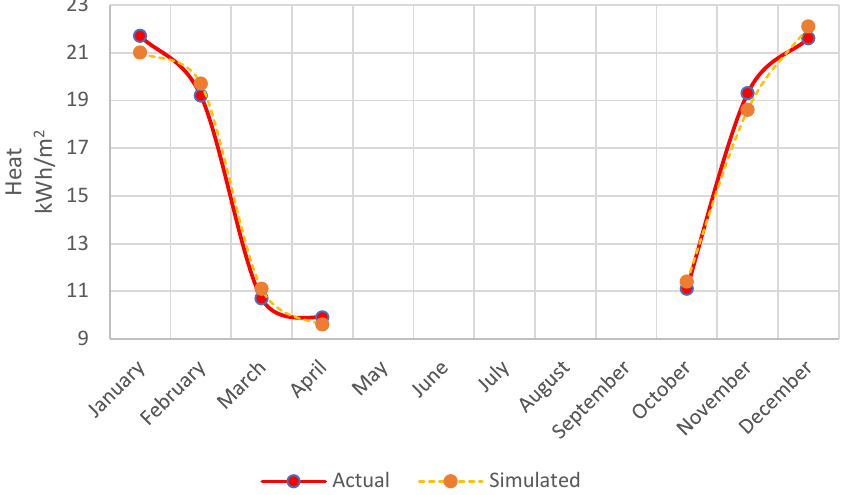
Figure 9. Validation — actual heat consumption and simulated demand of building “ D ” .